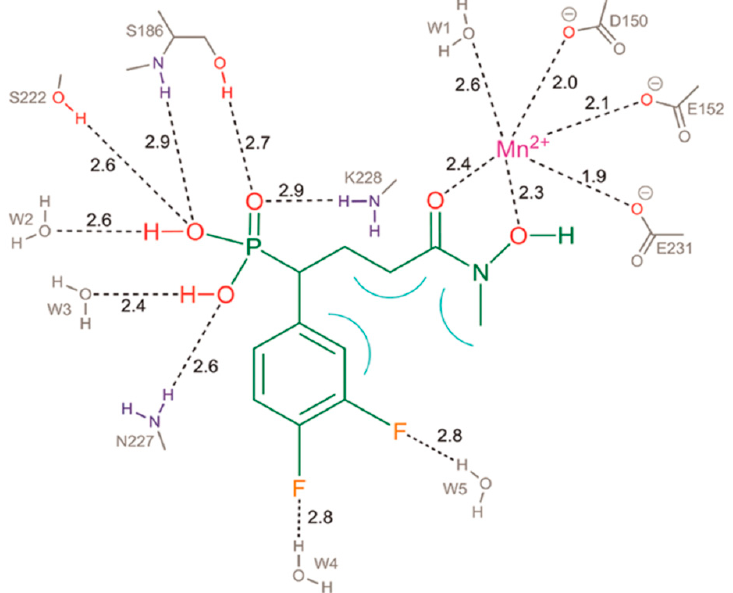
Figure 25. Schematic overview between 110b (green) and the active site of Ec DXR. Intramolecular van der Waals interactions (light blue) between the N -methyl group with the difluorophenyl ring and the linker atoms of 110b . Distances are in Å [100]. Reprinted with permission from J. Med. Chem. 2011, 54, 6796–6802 [100]. Copyright 2022 American Chemical Society.